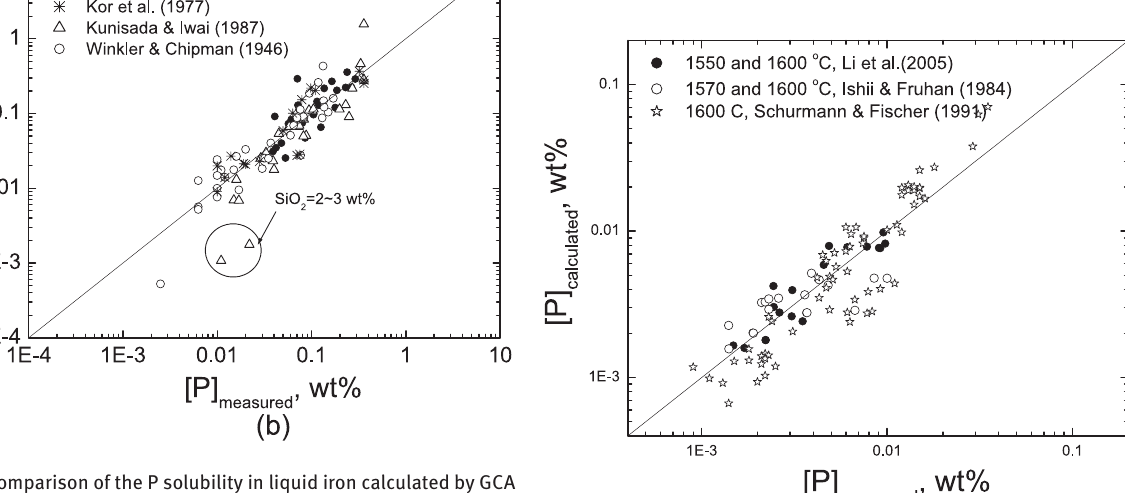
Fig. 6: Comparison of the model calculated P concentration in the liquid iron equilibrated with the Al O containing steelmaking slags 2 3 with the experimental data [20, 29, con- 2